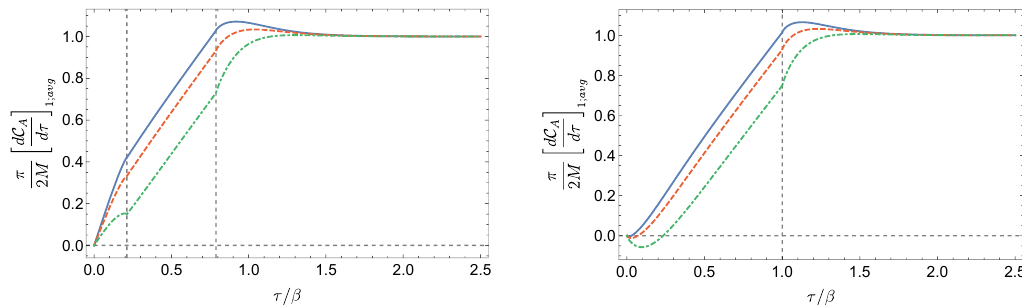
Figure 14 . The averaged rate of growth of complexity from eq. (2.43) (with (cid:13) = 1) as a function of time for the d = 3 planar black hole (left) and d = 4 planar (right). Results are shown for several values of the horizon radius | r h =L = 1 (blue), r h =L = 1 : 5 (dashed red) and r h =L = 3 : 5 (dot-dashed green). Note that, as in (cid:12)gures 2 and 4, smaller black holes violate the Lloyd bound more strongly. Note also, that the averaged derivative is discontinuous at j (cid:28)=(cid:12) (cid:6) 1 j = (cid:28) c =(cid:12) , where 2 for d = 3, (cid:28) c =(cid:12) = 1 and for d = 4, (cid:28) c =(cid:12) = 1 p 2 2 3